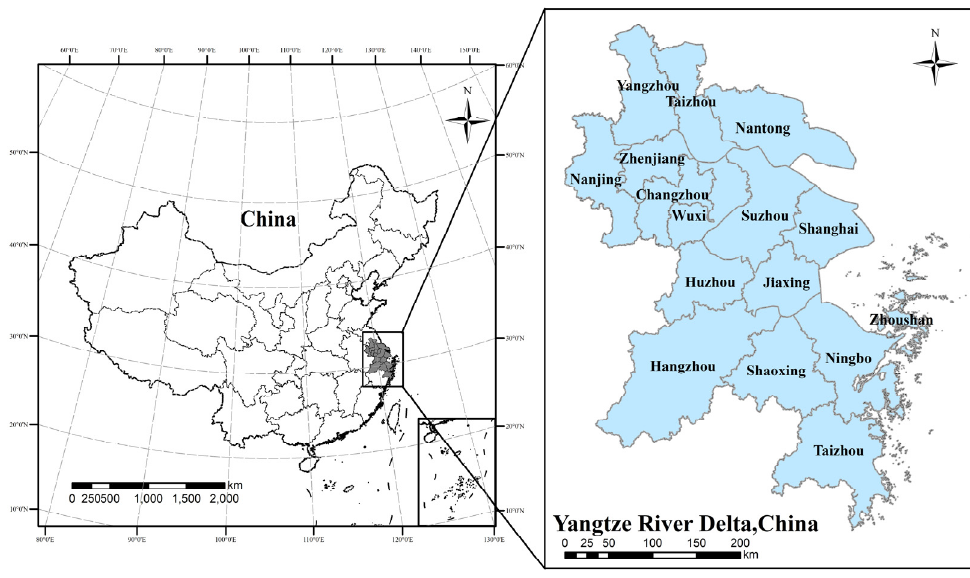
Figure 2. Location of the study area.